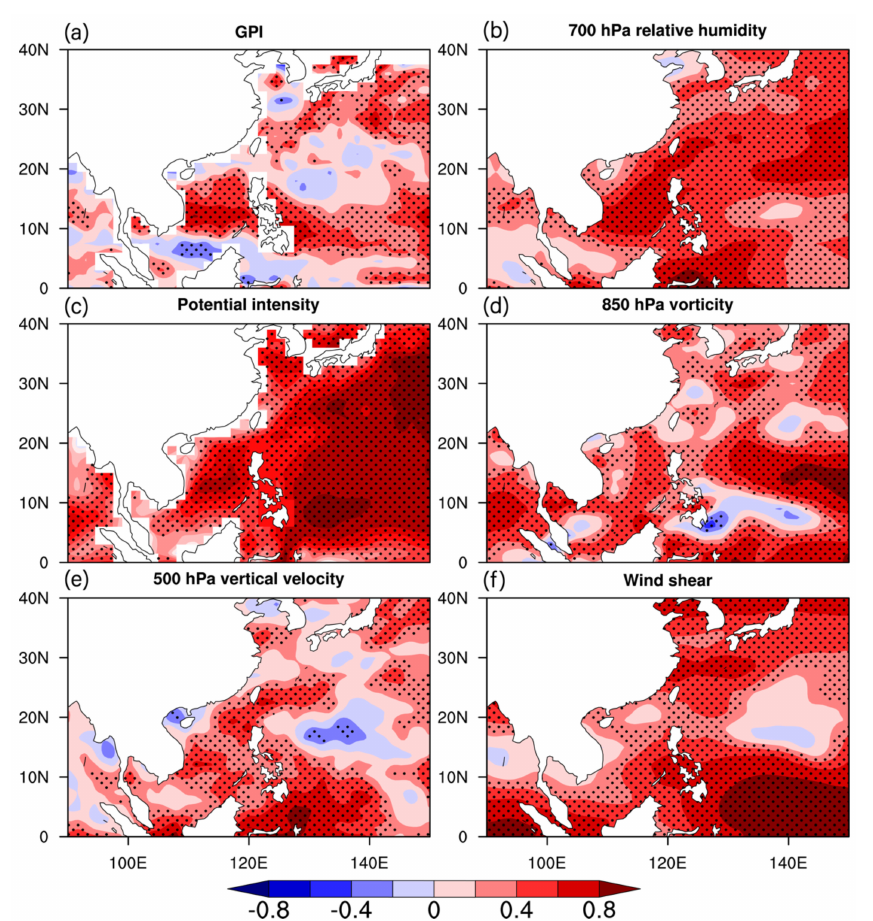
Figure 6. The temporal correlation coefficient (TCC) for the seasonal (July to November) tropical cyclone genesis potential index (GPI; a ), 700 hPa relative humidity ( b ), potential intensity ( c ), 850 hPa vorticity ( d ), 500 hPa vertical velocity ( e ), and wind shear ( f ) between the hindcast of FGOALS-f2 and the ERAI from 1981 to 2015. Black dot means the correlation coefficients that are significant at a two-sided P = 0.05